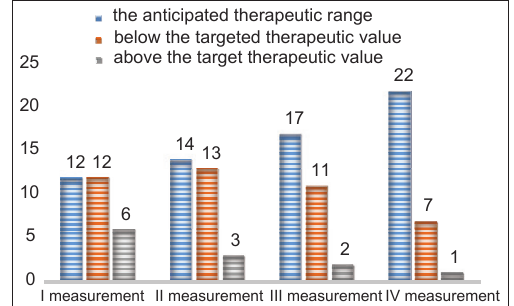
Figure 2. INR values during measurement period.